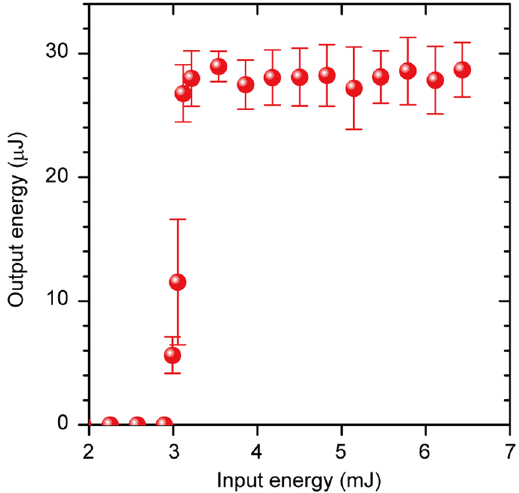
Figure 3. Output energy of magnetooptical (MO) Q-switch laser. Output energy versus pumping energy. The diode peak power was fixed at 32.2 W and the pumping duration was varied from 70 to 200 μ s. The pumping- pulse fall time and the magnetic-pulse rise time were set to constants.